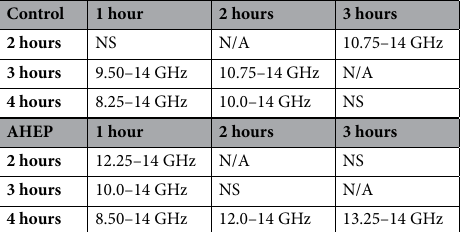
Table 1. Hourly based pairwise comparison for livers in the control and the AHEP group in vivo. The table shows the frequency ranges where statistical significance were found in each hourly pairwise comparison, for livers in the control group and AHEP group (comparison within the same group). “ NS ” = “Not Significant”, “ N/A ” = “Not Applicable”.